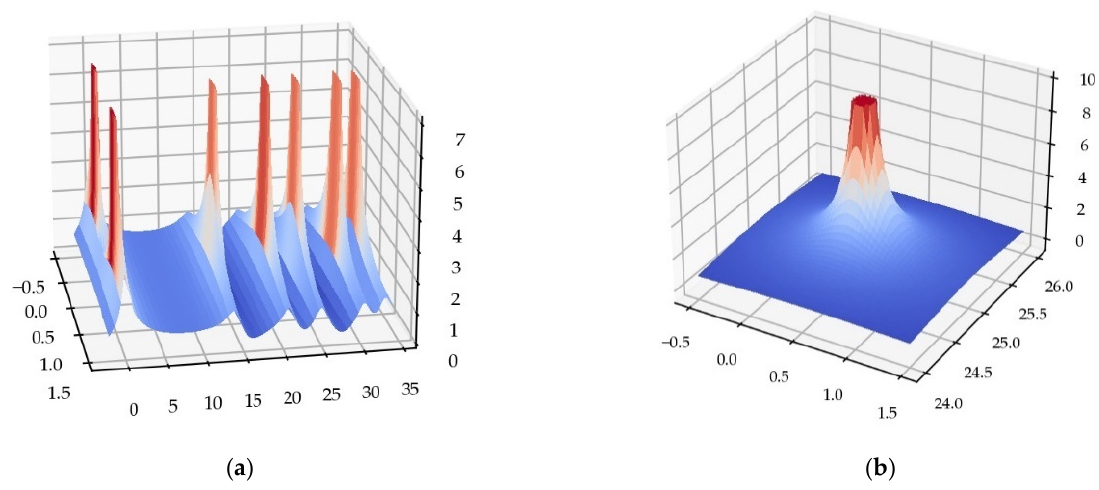
Figure 4. ( a ) The S function: absolute value of S ( s ) , presenting the ‘fairy chimneys’ of the function, on the CL, and the two poles in the CS. ( b ) 3D view of a single pole. We only display the bottom of these very tall chimneys, since these pedestals are important for our study.